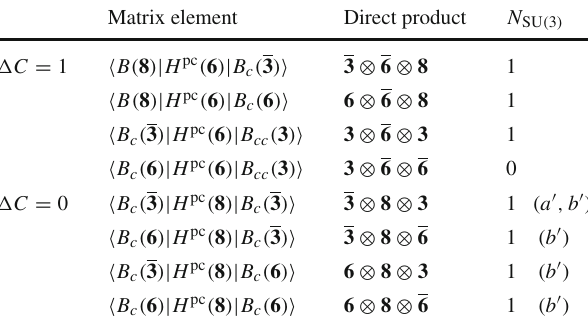
Table 14 SU(3) properties of the weak transition matrix elements Matrix